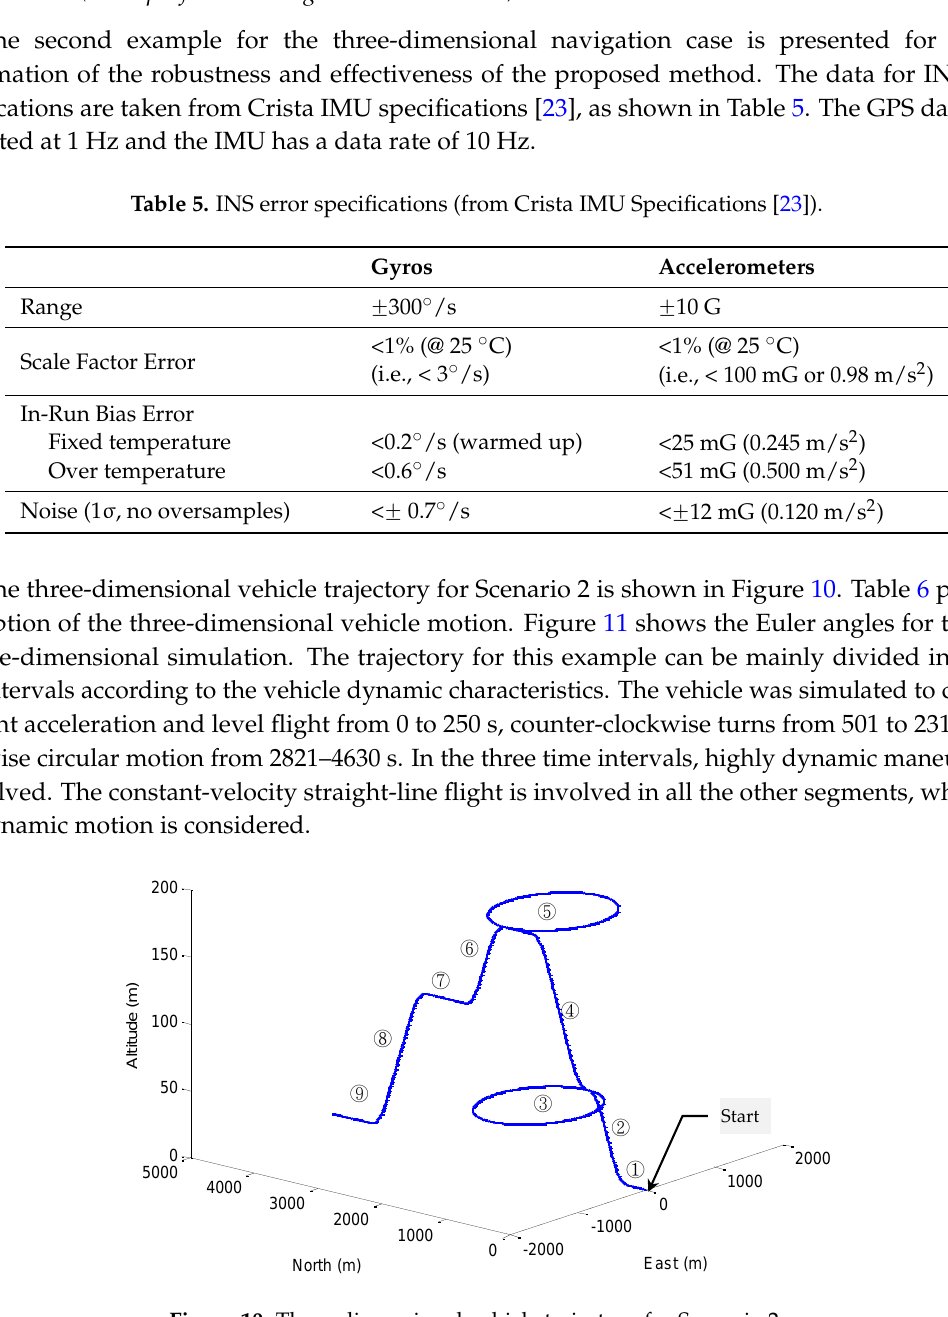
Table 5. INS error specifications (from Crista IMU Specifications [23]).